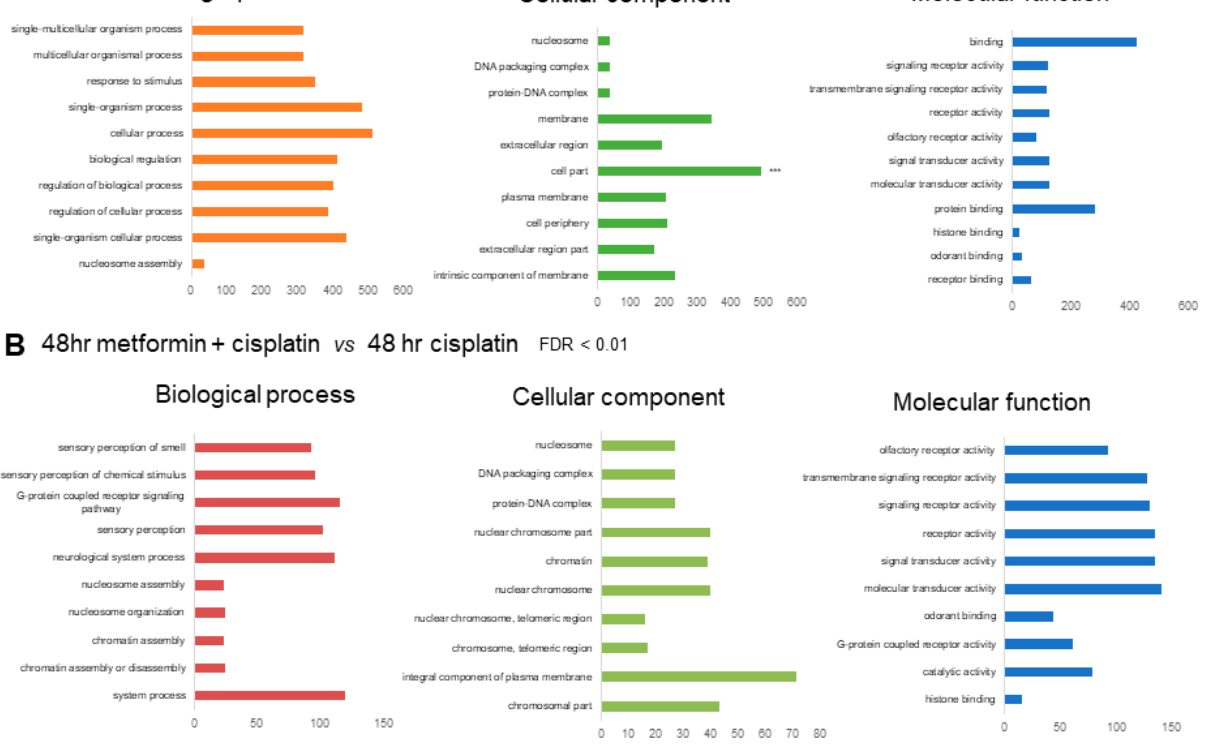
Figure 3. ( A ). GO annotation of predicted targets in 24 h metformin-pretreated group compared to the 24 h cisplatin group. The top 10 most enriched GO terms are listed in terms for biological process, cellular component, and molecular function based on p -values. ( B ). GO annotation of predicted targets in 48 h metformin-pretreated group compared to the 48 h cisplatin group. The top 10 most enriched GO terms are listed in terms for biological process, cellular component, and molecular function based on FDR <0.01.